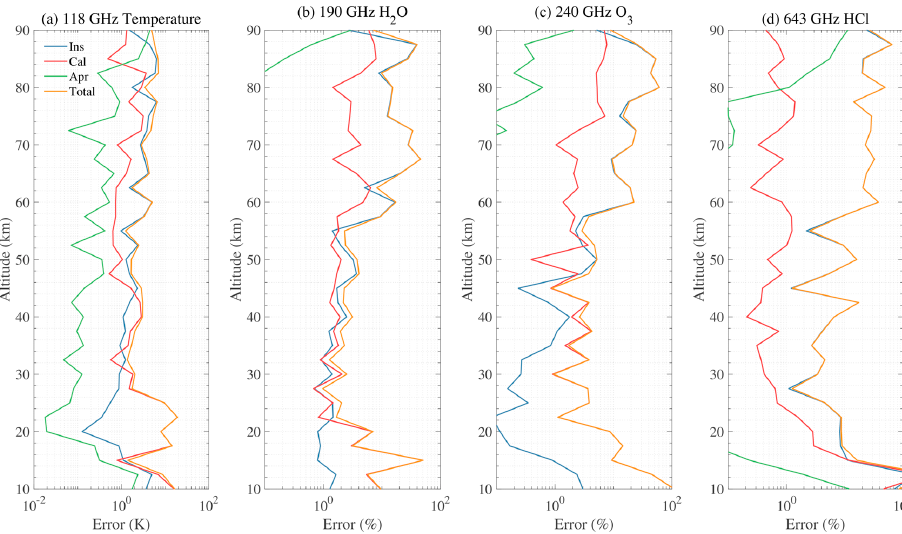
Figure 21. The overall retrieval errors estimation: ( a ) 118 GHz temperature retrieval; ( b ) 190 GHz H 2 O retrieval; ( c ) 240 GHz O 3 retrieval; ( d ) 643 GHz HCl retrieval. The errors are calculated by using the sum of squared errors.